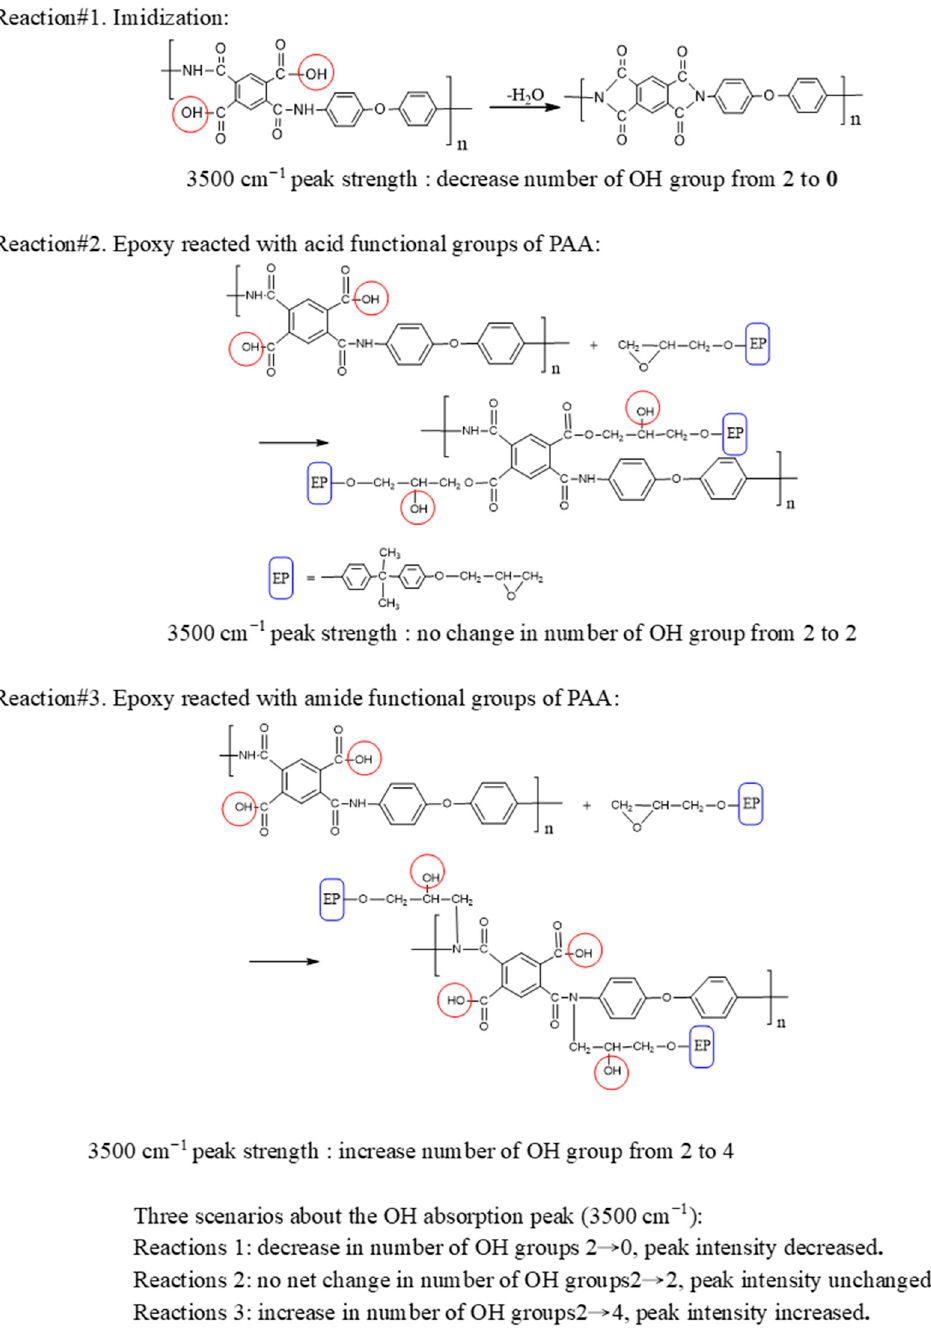
Figure 4. Reactions of acid or amide function groups of PAA with EP, as well as imidization reac- tion.